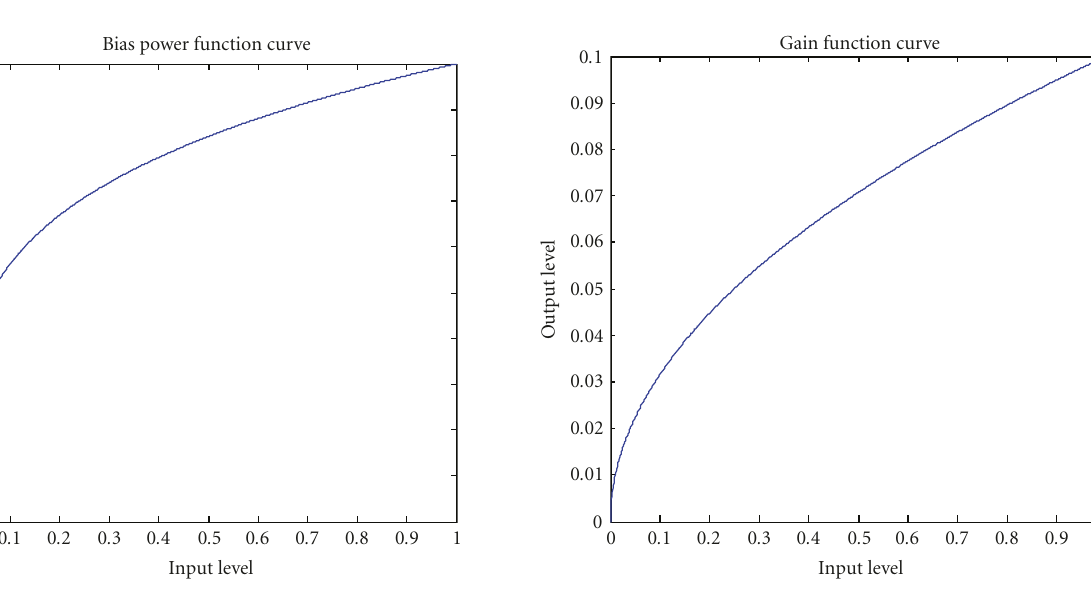
Figure 12: Bias power function curve for di ff erent mean’s value. Figure 13: Gain function curve for di ff erent variance’s